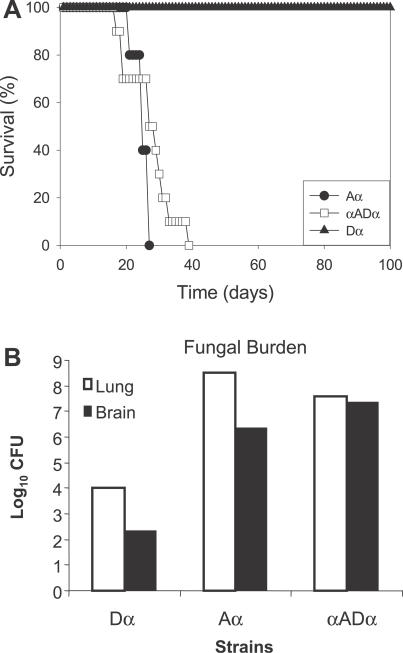
αADα Hybrid Is as Virulent as the More Virulent Serotype A ParentSerotype A (KN99α, Aα) and D (JEC21, Dα) reference stains and the isogenic laboratory-constructed αADα hybrid (XL1462, αADα) were grown in liquid YPD medium overnight at 37 °C and washed three times with PBS. Mice were infected intranasally with 5 × 104 fungal cells and monitored for 100 d.(A) Survival is plotted against time after inoculation. The αADα hybrid is as virulent as the Aα parental strain (p = 0.371), and both the Aα and the αADα hybrid are more virulent than the Dα strain (p = 0.0007 and p < 0.0001 respectively).(B) The average number of colony-forming units (CFU) of fungal cells from the organs (lungs and brains) of two infected animals is shown.